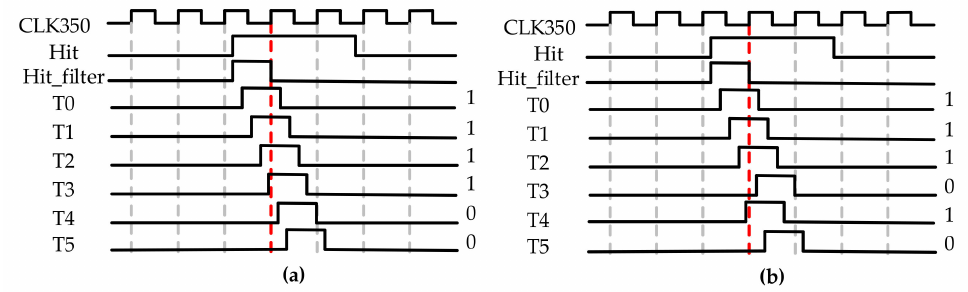
Figure 3. Timing diagram of a tapped delay line: ( a ) the tap sequence is consistent with the order of taps; ( b ) the tap sequence is not consistent with the order of taps.